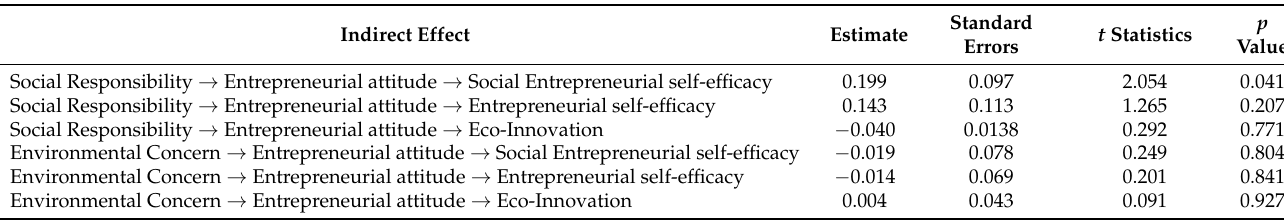
Table 3. Bootstrap results for indirect